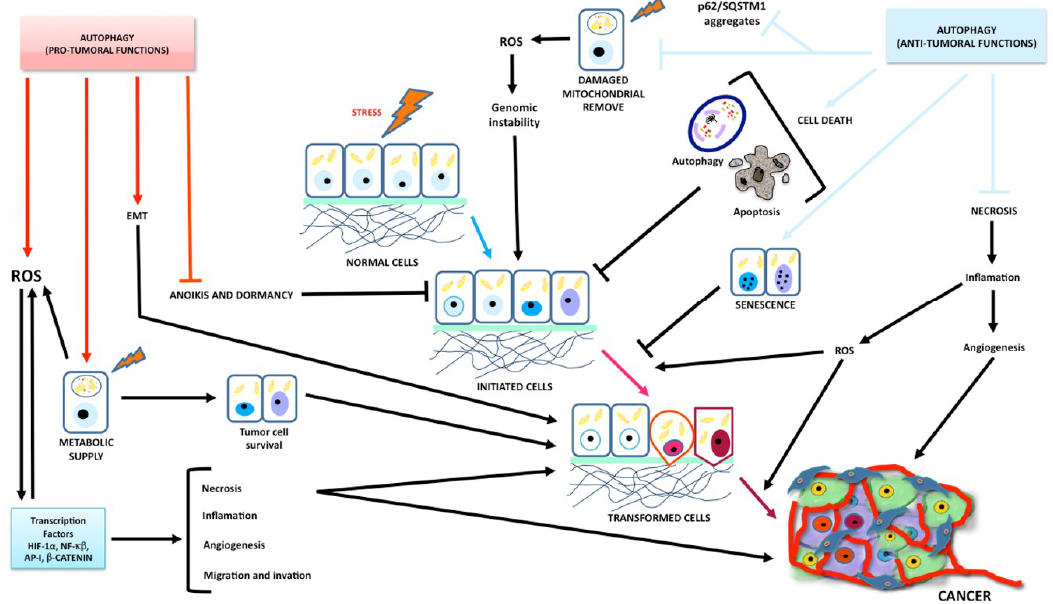
Figure 5. The role of autophagy in the suppressing and promoting tumorigenesis. As a tumor suppressor, autophagy prevents the accumulation of damaged proteins and mitochondria, protecting the cell from oxidative stress and the subsequent genomic instability, necrosis, and inflammatory processes that lead to tumor migration and invasion. If autophagy is excessive, this can lead to type-II programmed cell death, which can induce apoptosis, in addition to activate senescence. In contrast, autophagy sustains tumor survival and growth in adverse conditions (hypoxia and metabolic, osmotic, and oxidative stress) by degrading misfolded or unnecessary proteins and organelles to mobilize nutritional elements like amino acids, lipids, and carbohydrates, promoting cell survival. It also increases oncogenic signals that favor necrosis, inflammation, angiogenesis, migration, and tumor invasion; additionally, it inhibits the anoikis and dormancy. Continue arrows ( ) mean activation and truncated arrows ( ) mean inhibition.